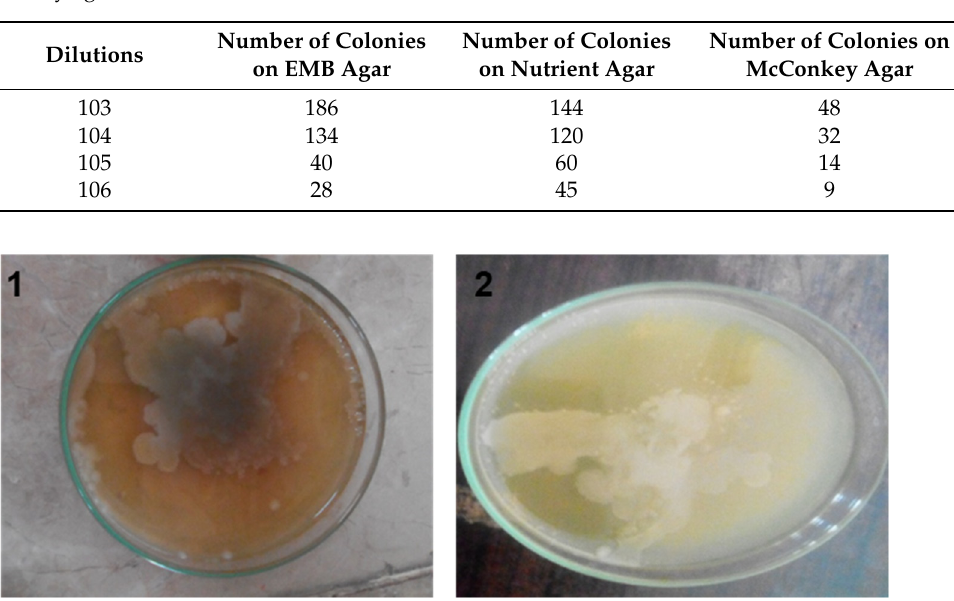
Table 2. Viable counts of the colonies on eosin methylene blue agar, nutrient agar, and on Mac- Conkey agar.